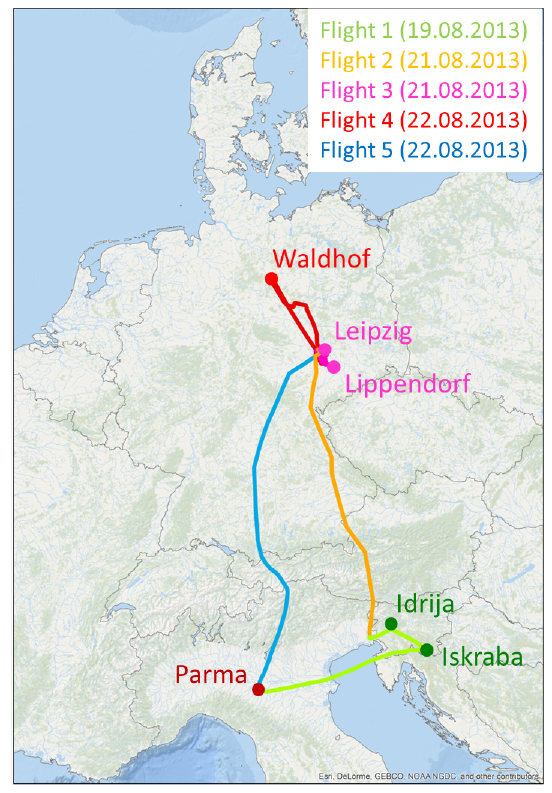
Figure 1. Flight tracks of the European Tropospheric Mercury Ex- periment part 2 (ETMEP-2) research flights in August 2013. Flights are separated by the flight track colour. The home base of the used aircraft was Parma, Italy. Vertical profiles were flown over Iskraba and Idrija (Slovenia), and Lippendorf, Leipzig, and Waldhof (Ger-